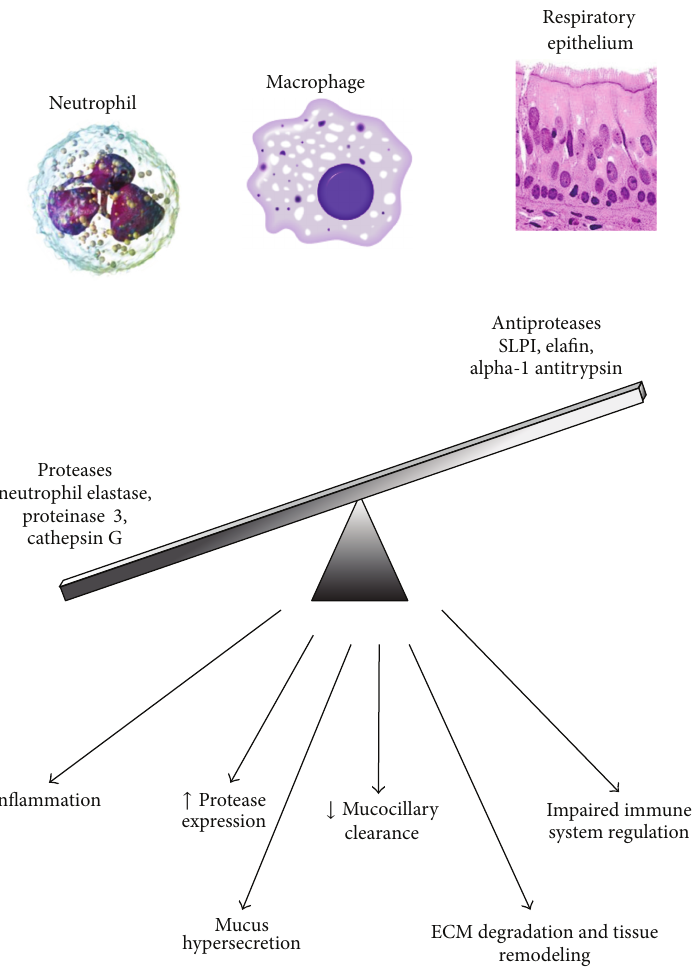
Figure 1: In the cystic fibrosis lung, antiprotease production by both innate immune cells and respiratory epithelial cells is overwhelmed by protease production resulting mainly from neutrophils. This leads to a disruption of the homeostatic protease/antiprotease balance resulting in a number of detrimental effects causing increase lung